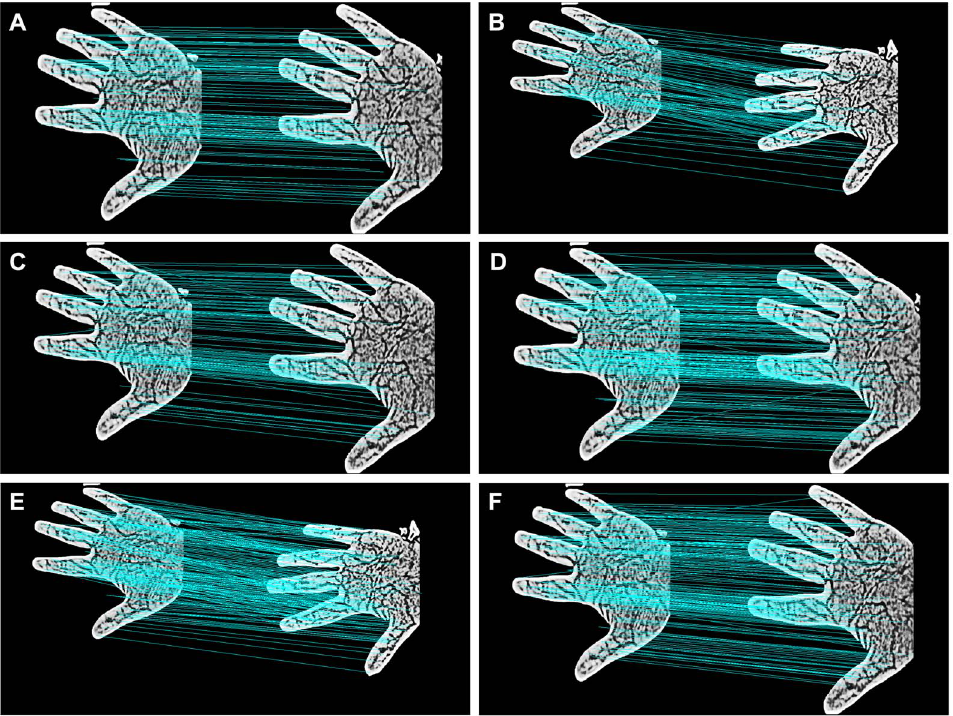
Figure 5. SIFT ((a), (b), (c)) and RootSIFT ((d), (e), (f)) are compared for their robustness against rotation and scale transformations.